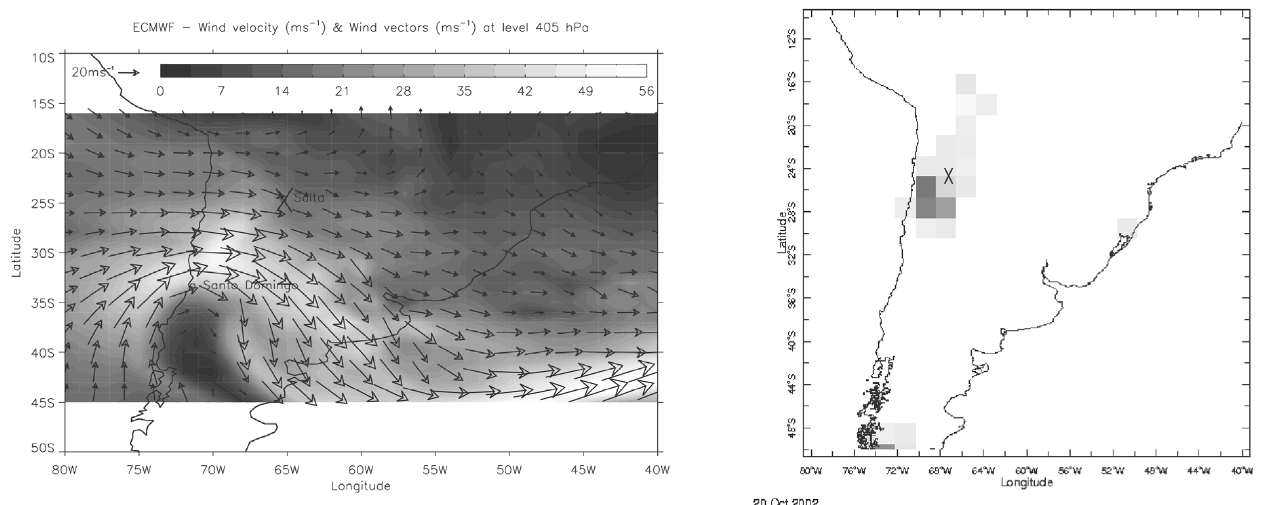
Fig. 16. Case 3: Reanalyses results. Left: ECMWF wind velocity given by the levels of grey at the 405hPa level (altitude ∼ 5.5km). Wind vectors at the corresponding level are superimposed. Right: NCEP-NCAR reanalysis, daily mean zonal gravity wave drag (darker zones correspond to stronger forcing by gravity waves). Salta location is indicated by a cross.